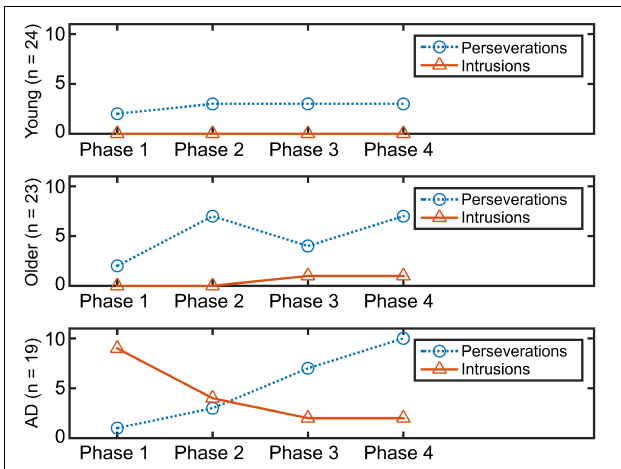
FIGURE 3 | Time course of each error in four